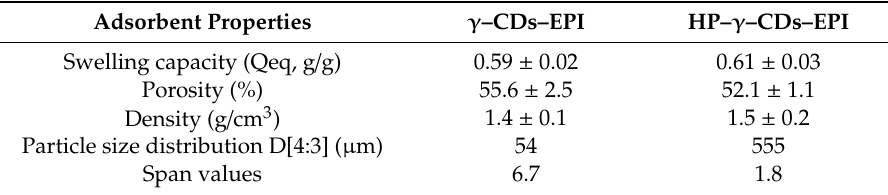
Table 1. Properties of both polymeric adsorbents.